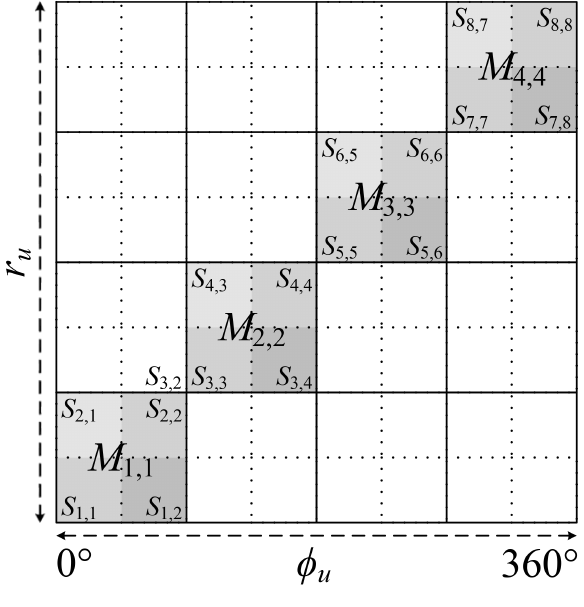
Figure 3. Subdivisions of